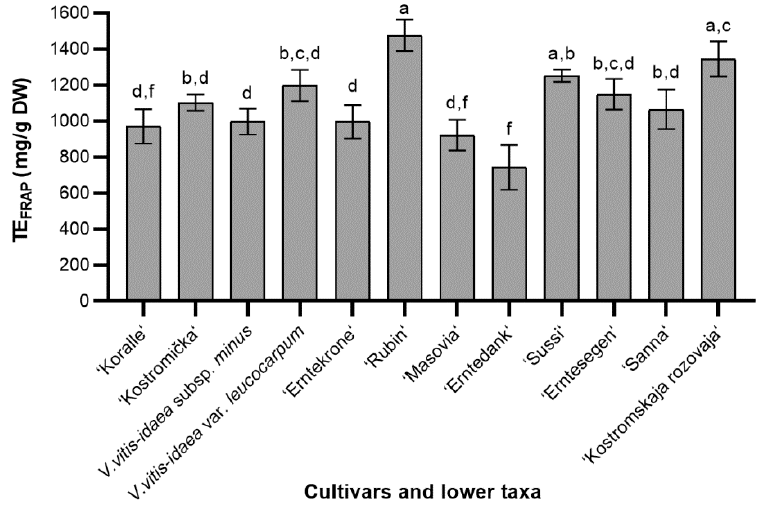
Figure 2. The reducing activity of different cultivars and lower taxa of lingonberry leaves extracts; bars without the same letters (a, b, c, d, f) indicate statistically significant differences between the means ( p < 0.05).